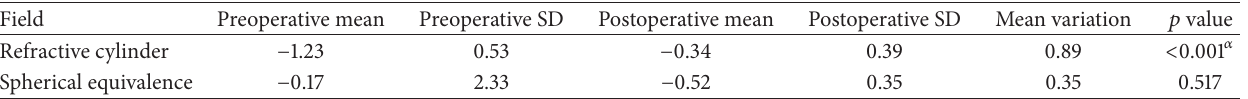
Table 3: Refraction results. The table shows a statistically significant variation in terms of preoperative and postoperative refractive cylinder values, as well as a lack of statistically significant differences between preoperative and postoperative spherical equivalence.